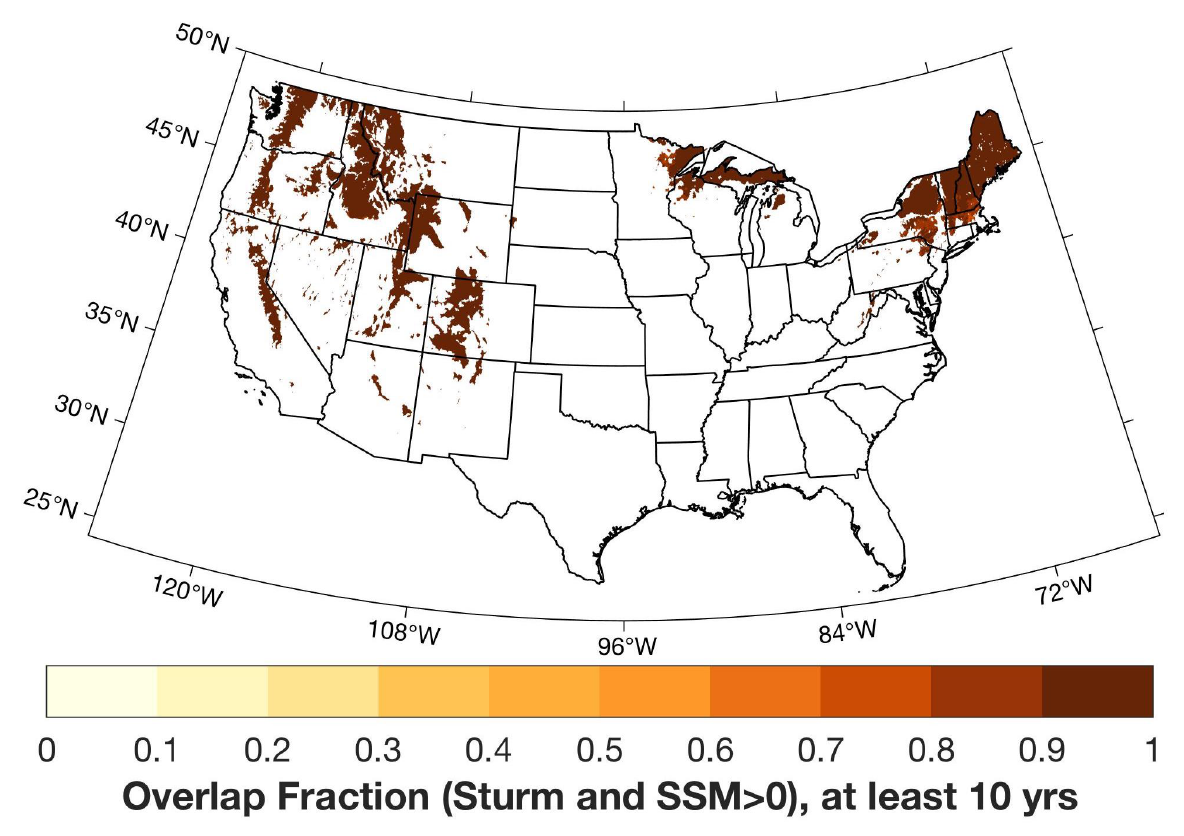
Figure 3. Agreement (overlap fraction) between seasonal snowpacks identified via the snow seasonality metric and Sturm seasonality classification schemes. Only grid cells with at least 10 years of snow observations were